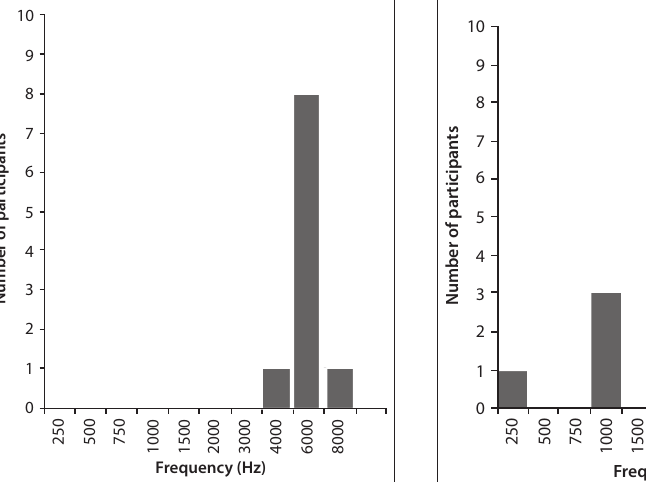
Fig. 2. Tinnitus pitch matching for group B (non- TMD group).